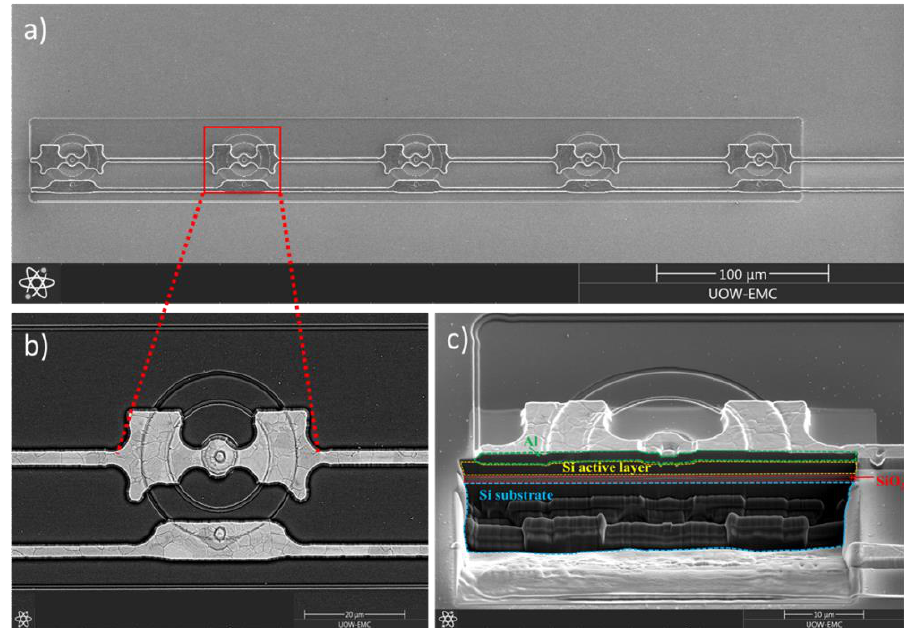
Figure 2. Scanning electron microscope (SEM) image of the 2-µm-thick Mushroom microdosimeter. ( a ) A surface scan showing a number of SVs, ( b ) a zoomed-in image of a single SV and ( c ) a cross- sectional scan of a single SV.